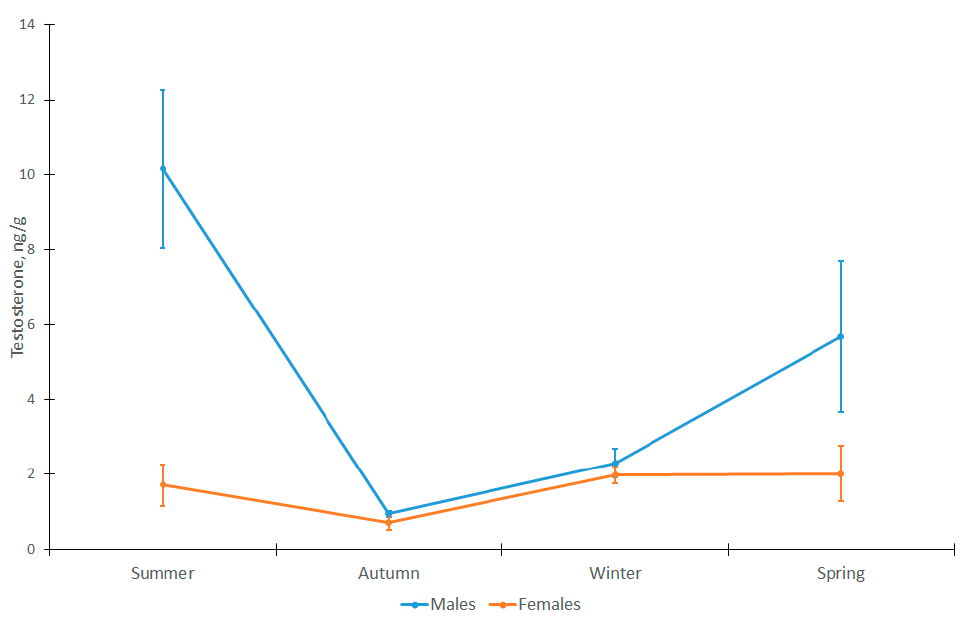
Figure 1. Testosterone concentration in hair of male and female domestic cats (males n = 5; females n = 12).